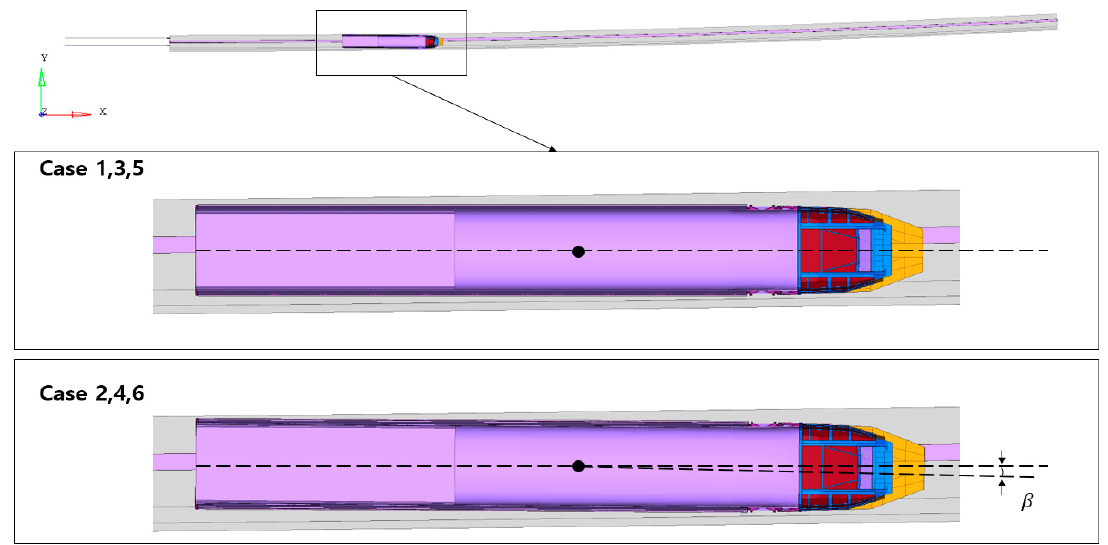
Figure 13. Conditions of impact angle in simulation.